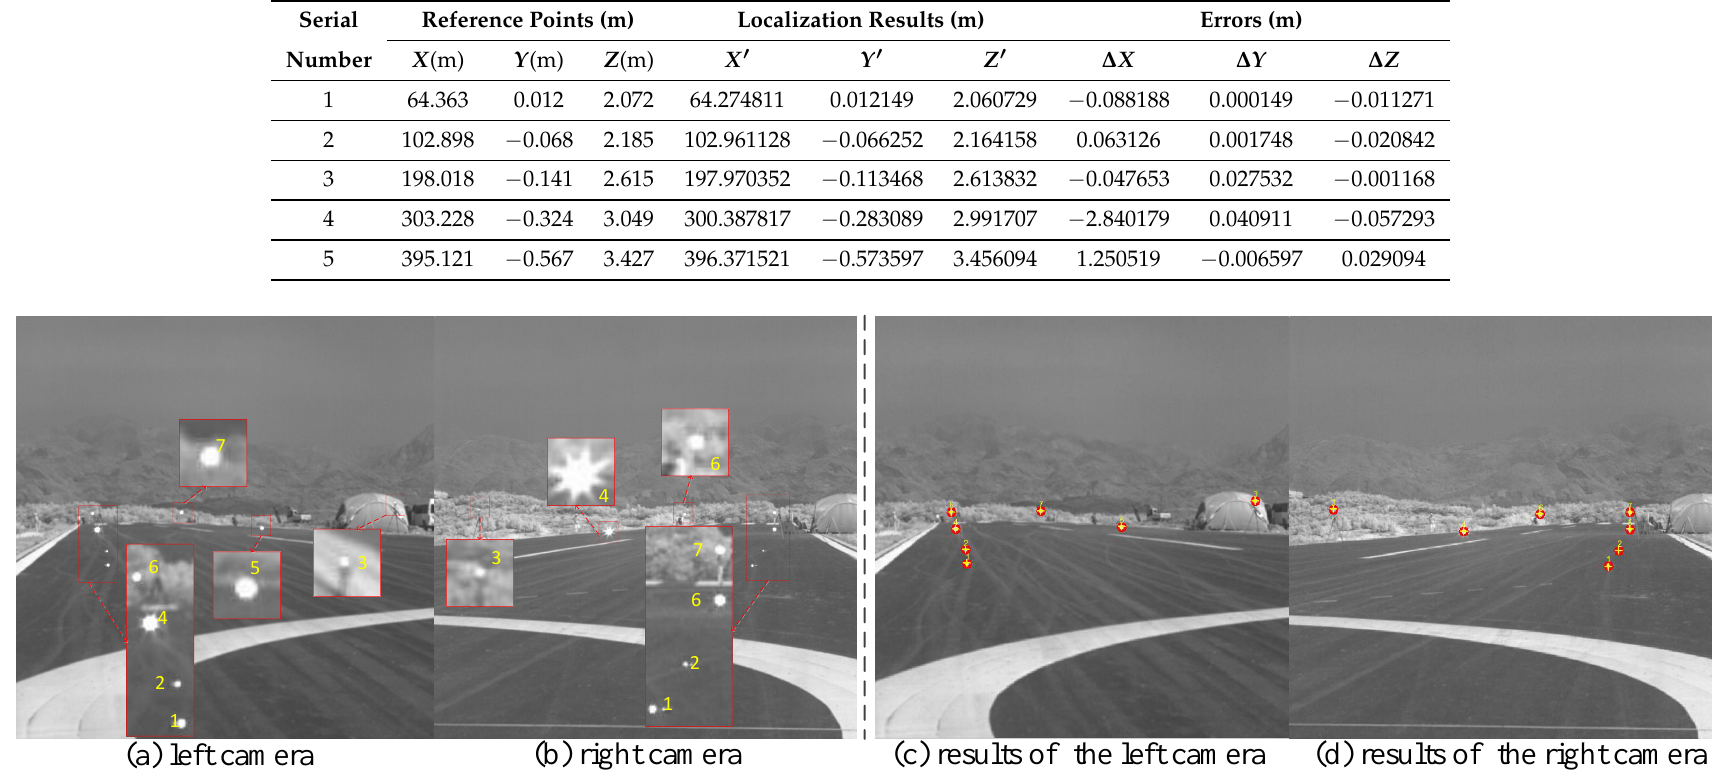
(d) results of the right camera(a) left camera